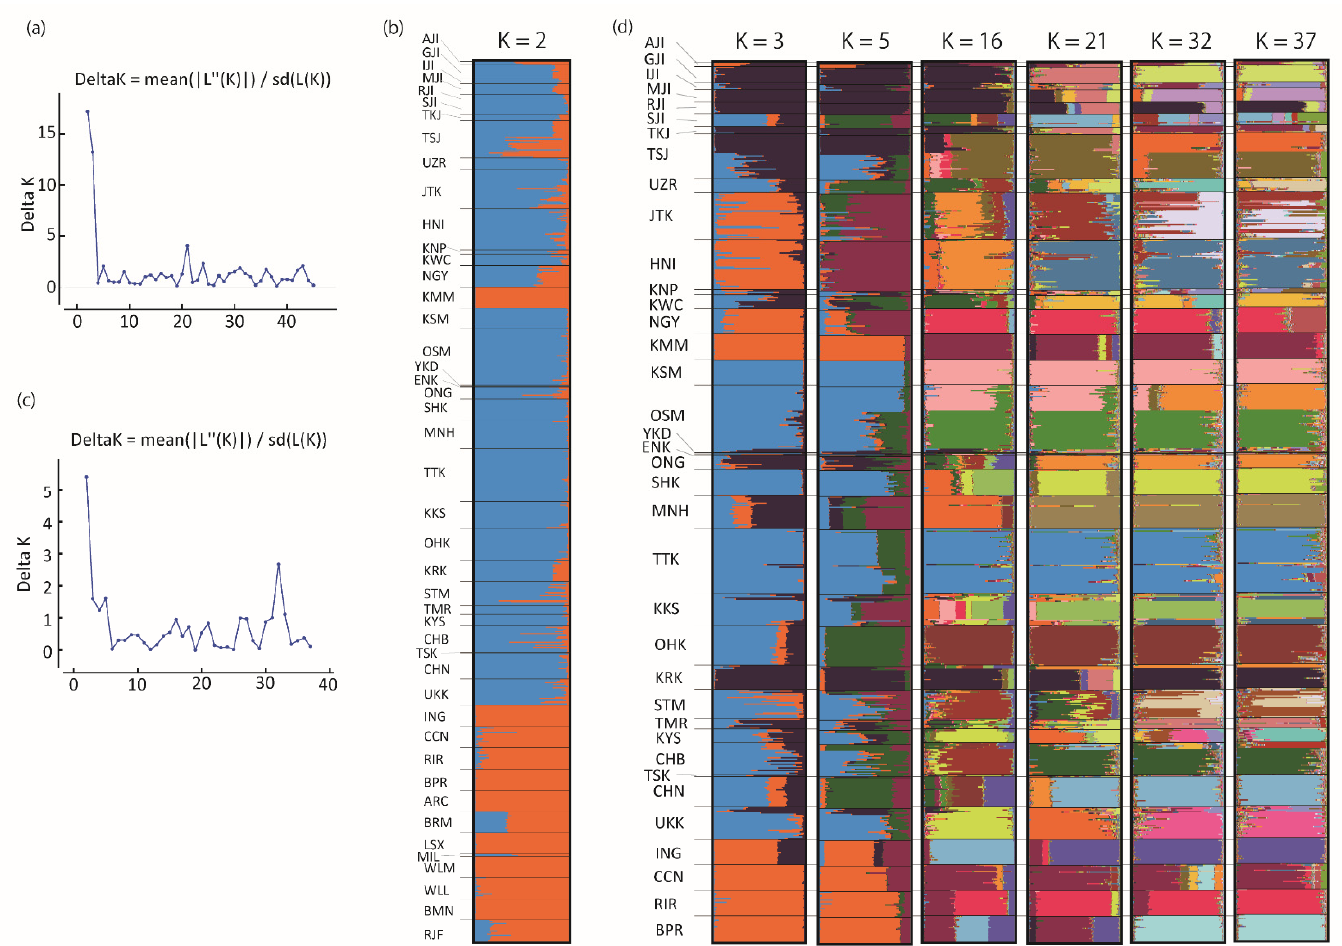
Figure 4. STRUCTURE plots of 37 Japanese indigenous chicken breeds, 7 chicken breeds from foreign countries, and one red junglefowl population. ( a ) Delta K values from K = 2 to K = 46 for all of 45 chicken breeds and populations. ( c ) Delta K values from K = 2 to K = 38 for 37 Japanese indigenous chicken breeds. ( b ) Group memberships to K = 2 clusters of 45 chicken breeds. ( d ) Group memberships to “K” clusters of 37 Japanese indigenous chicken breeds (K = 3, 5, 16, 21, 32, and 37). Genetic clusters are represented in different colors.